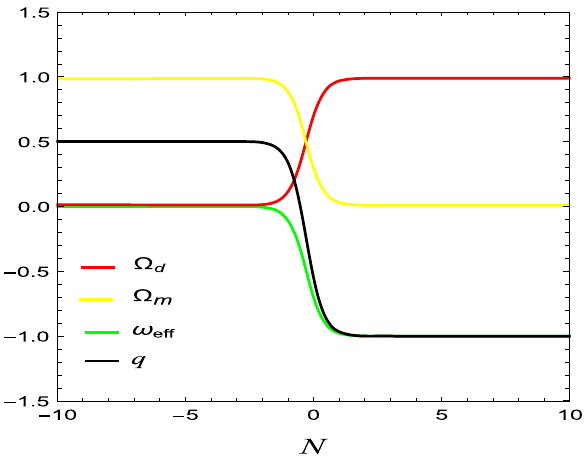
Fig. 4 Time evolution of physical parameters shows that late time attractor is ( Λ CDM) achieved by the cosmological constant like fluid for the autonomous system (12) with the parameter values ω = 1 . 5, γ = 0 . 001and λ = 0 . m